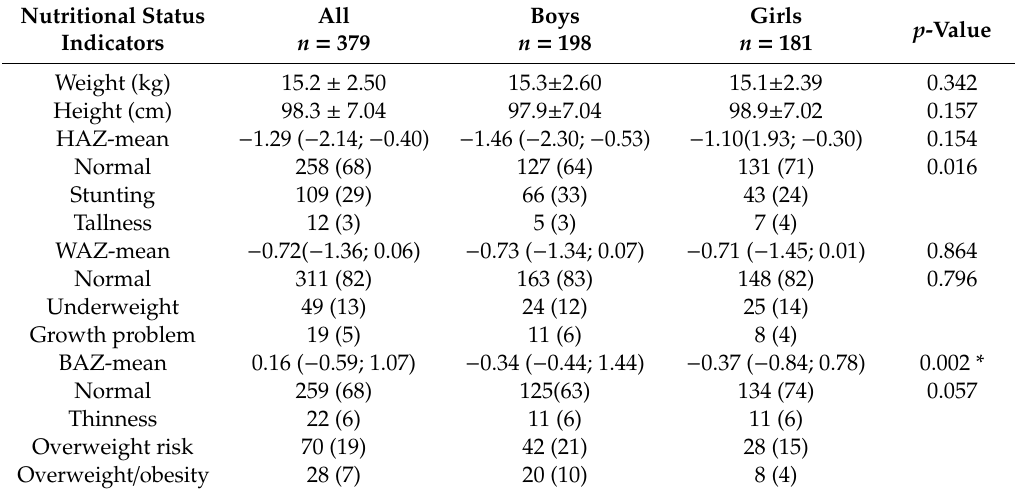
Table 2. Comparison of anthropometric values and nutritional status indicators of children by